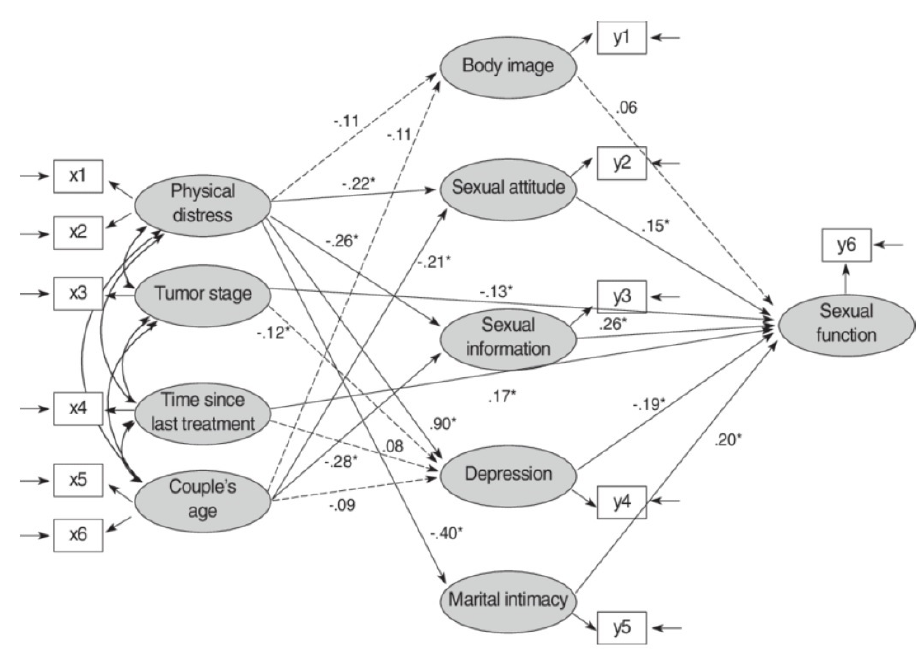
Fig. 3 The model of the influencing factors of the fractional differential equation for the transfer of teacher information technology application